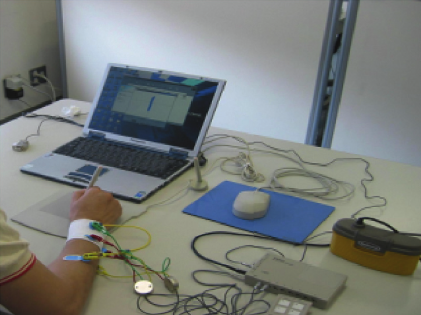
Figure 3: Experimental approach.